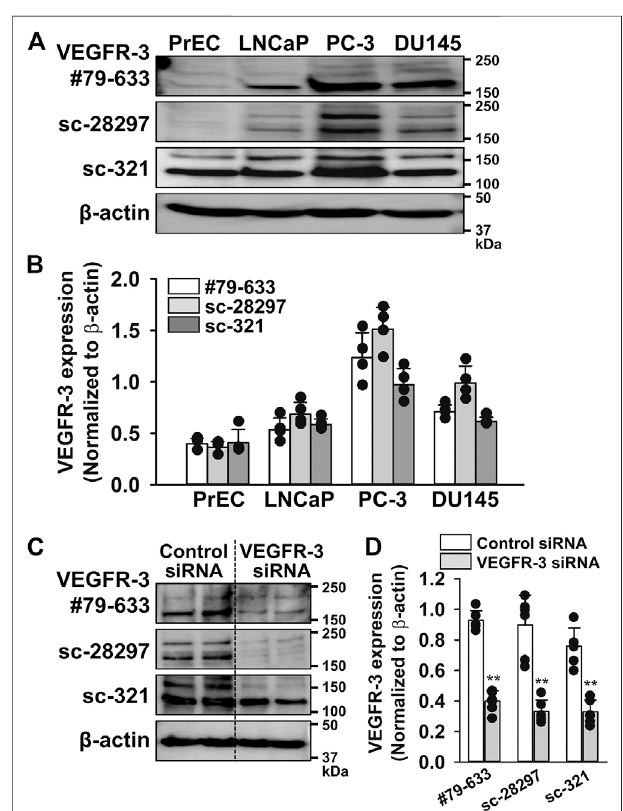
FIGURE 2 | Abundant expression of VEGFR-3 in PC-3 cells. The expression of VEGFR-3 protein was examined in PrEC, LNCaP, PC-3, and DU145 cellsby Western blottingusing three differentantibodies forVEGFR-3. (A) RepresentativeblotsofVEGFR-3inPrEC,LNCaP,PC-3,andDU145 cells using three different VEGFR-3 antibodies: #79-633 (ProSci), sc-28297, and sc-321 (Santa Cruz Biotechnology). (B) Expression level of VEGFR-3 in PrEC, LNCaP, PC-3, and DU145 cells ( n (cid:1) 4). The expression level of VEGFR- 3 were normalized by that of β -actin. (C) Representative blots of VEGFR-3 in PC-3 cells treated with 50 nM control or VEGFR-3 siRNA for 48 h. (D) Expression level of VEGFR-3 in PC-3 cells treated with control or VEGFR-3 siRNA ( n (cid:1) 6). Data are presented as means ± S.D. ** p < 0.01 vs. control siRNA (unpaired two-tailed t